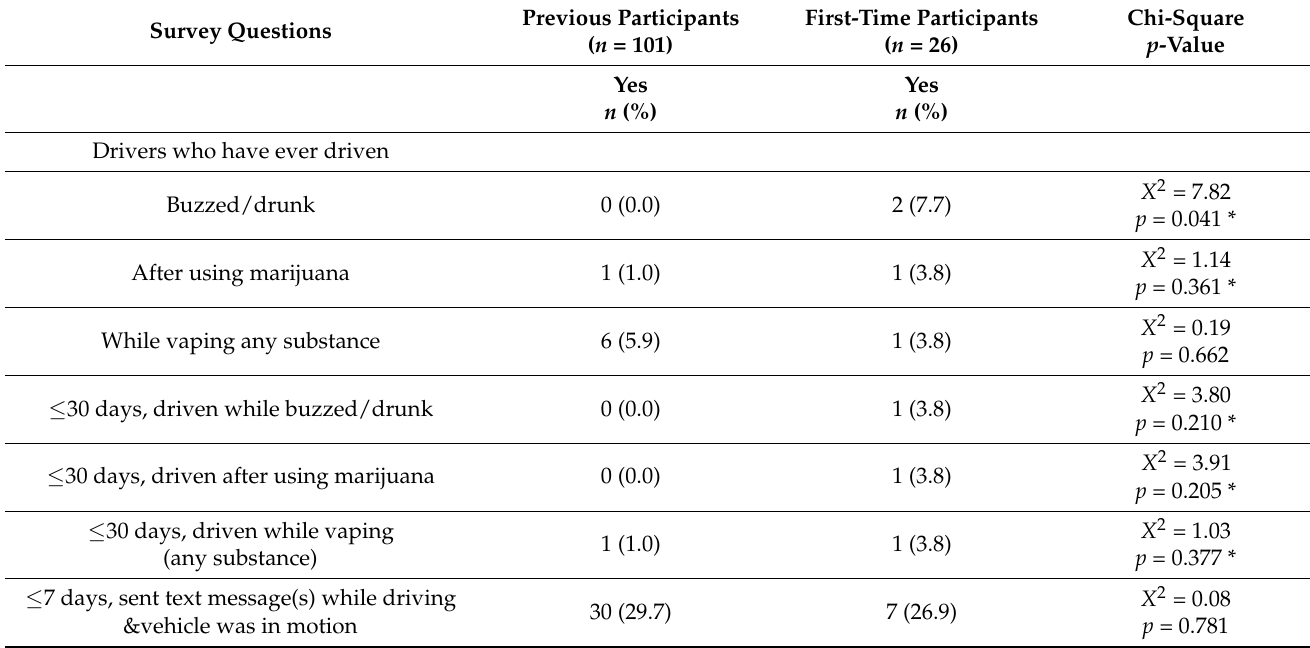
Table 3. Driver Baseline Behavioral Responses ( n =